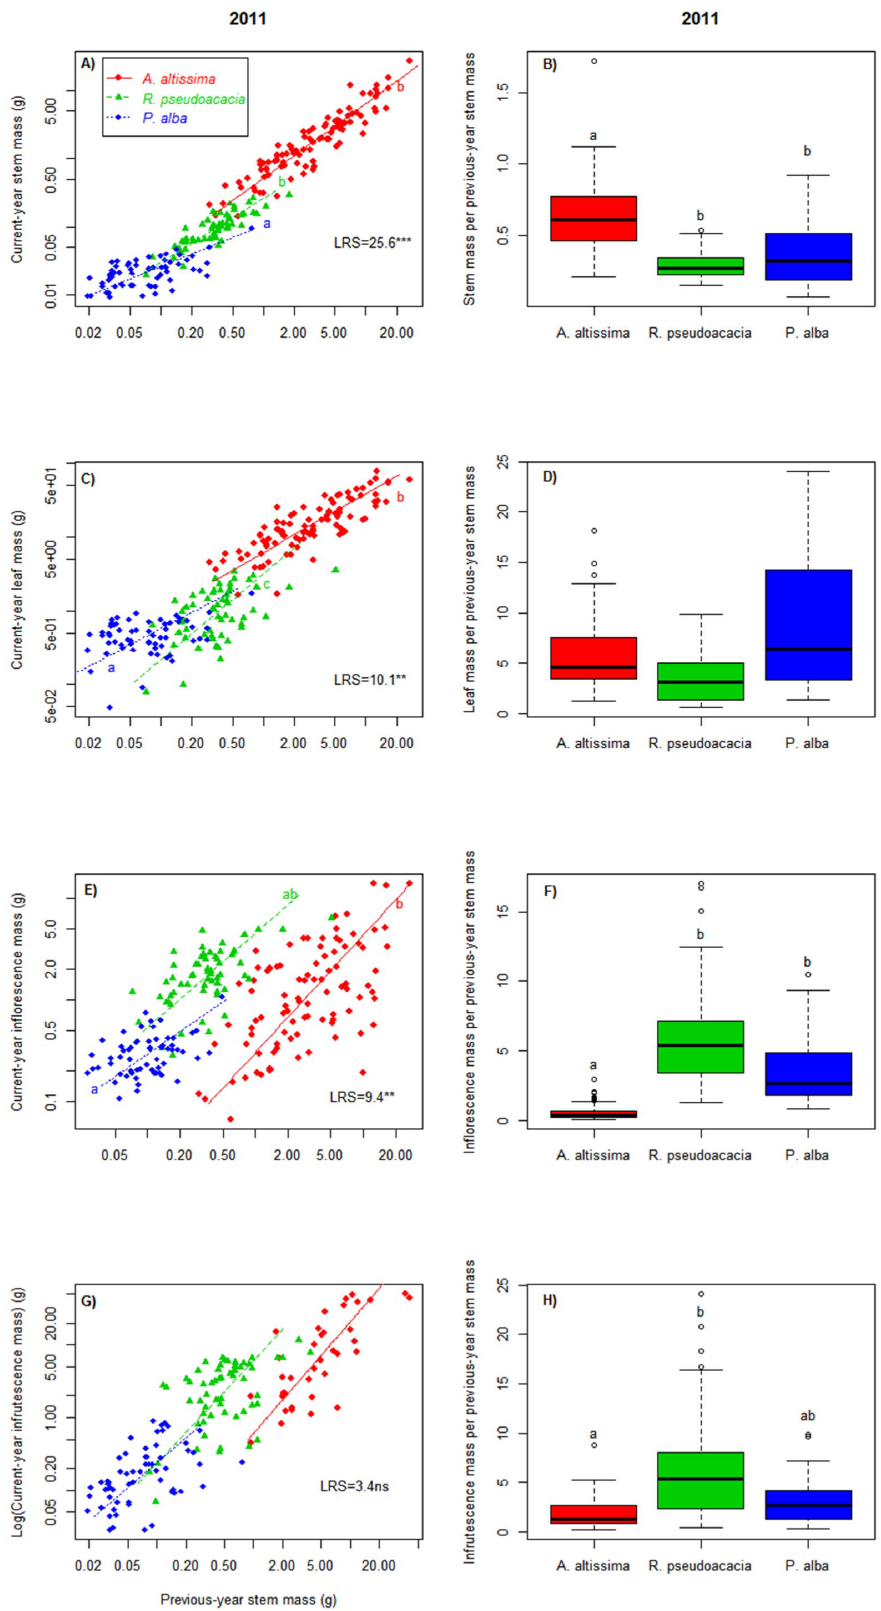
Figure 2. Species branch production in 2011. Left: Allometric relationships between previous-year stem mass and current year stem (A), leaf (C), inflorescence (E) and infrutescence (G) mass (note the log-scale of both axes). The Likelihood Ratio Statistic (LRS) comparing slopes across species and